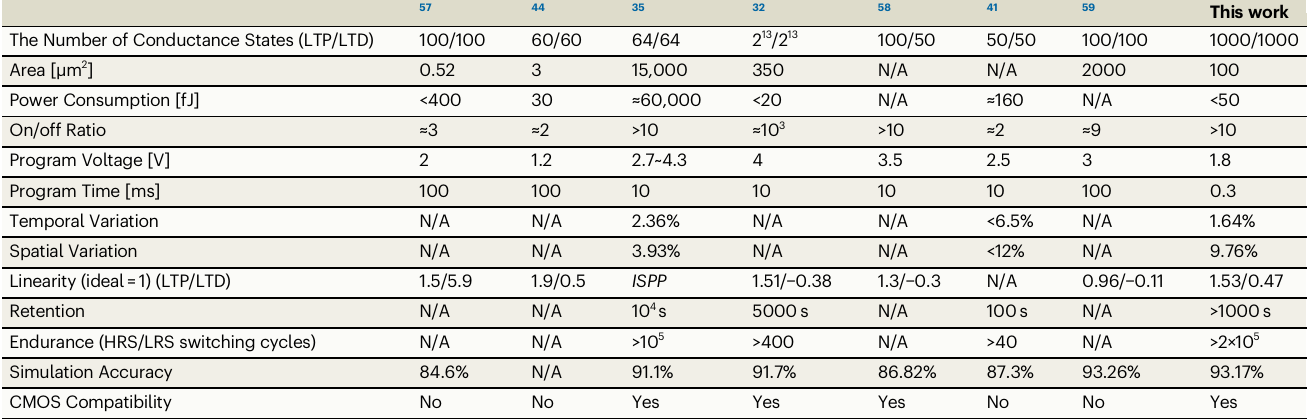
ISPP (IncrementalStepPulse Programming)is notidentical